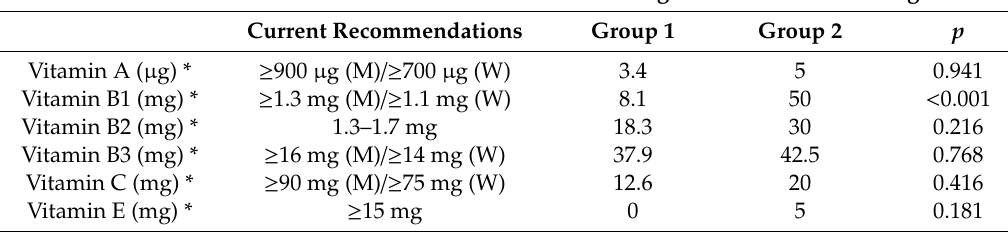
Table 7. Recommended daily dietary intake (mean ± SD) of vitamins and percentage of patients within the target value, according to the daily sodium intake (Group 1: < 1500 mg; Group 2: ≥ 1500 mg). M, men; W,